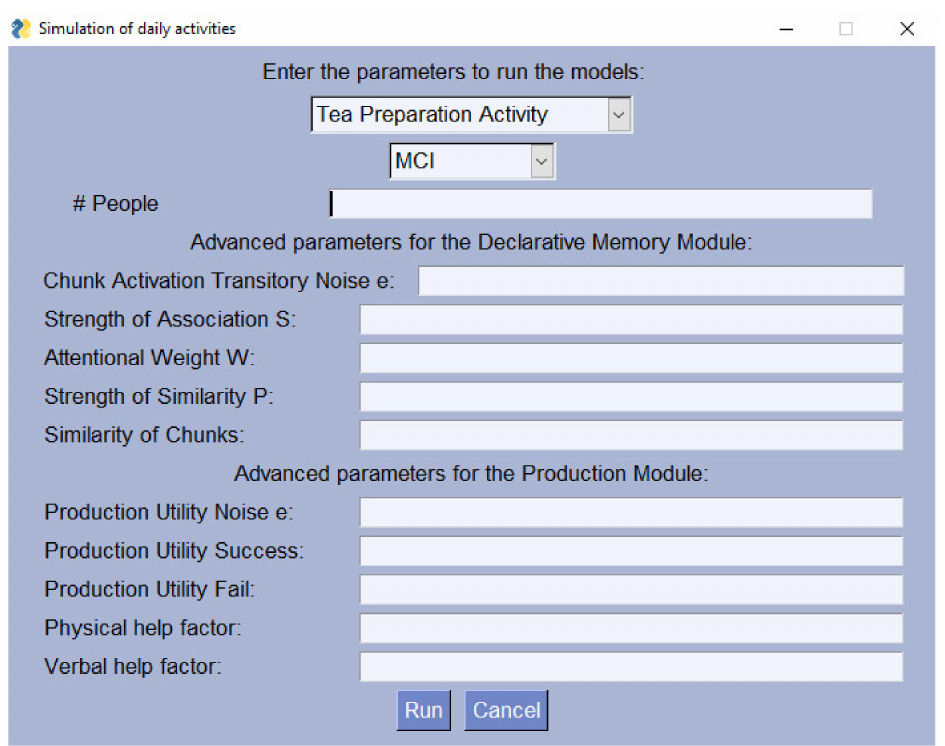
Figure 3. Main graphical interface of the conceptual framework. The required inputs are the activity, the level of AD, and the number of people to run the